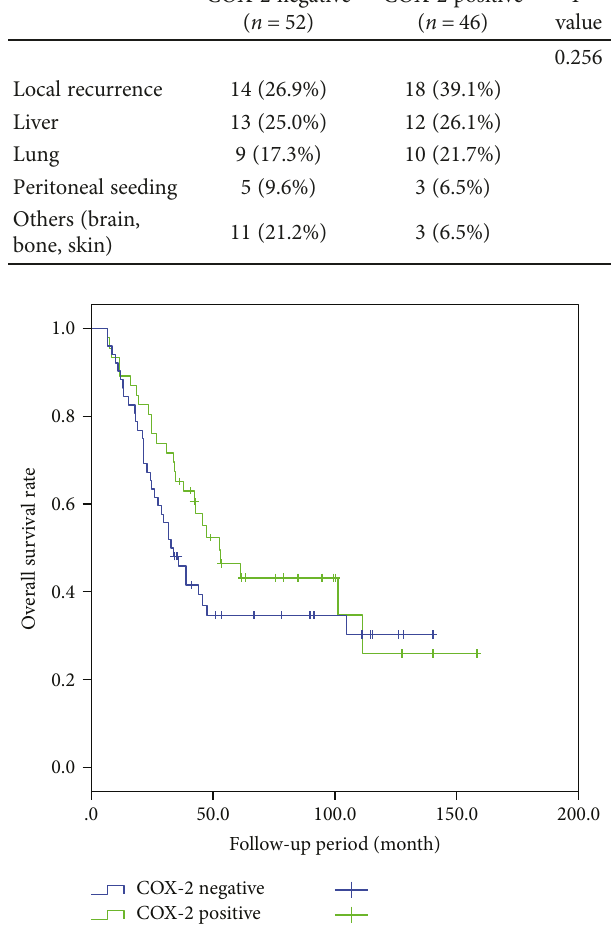
Figure 2: Postrecurrence survival was not signi fi cantly di ff erent according to the COX-2 status of the 98 patients with recurrence ( P = 0 230